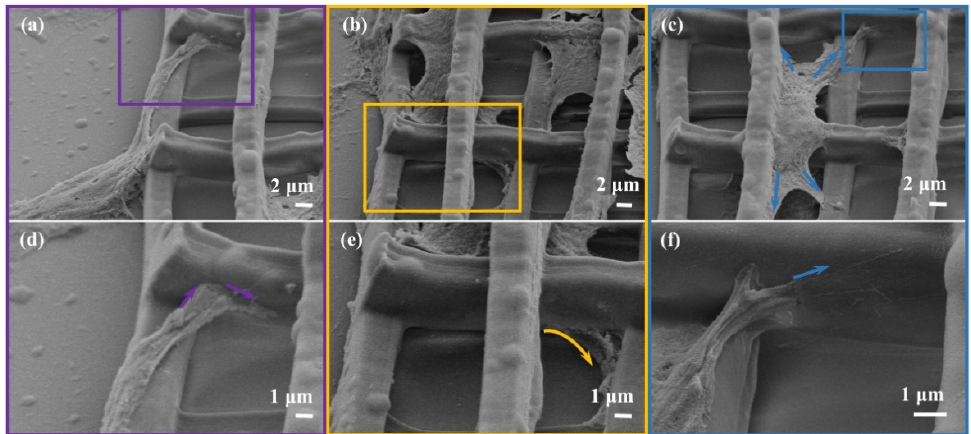
Figure 10. Cell–scaffold interactions. ( a , d ) SEM images of the cell on the flat surface climbing up to the edge of the 3D microscaffold. ( b , e ) SEM images of the cells inside the 3D microscaffold getting through the bottom of the strut. ( c , f ) SEM images of the cells inside the 3D microscaffold spreading up along the strut.